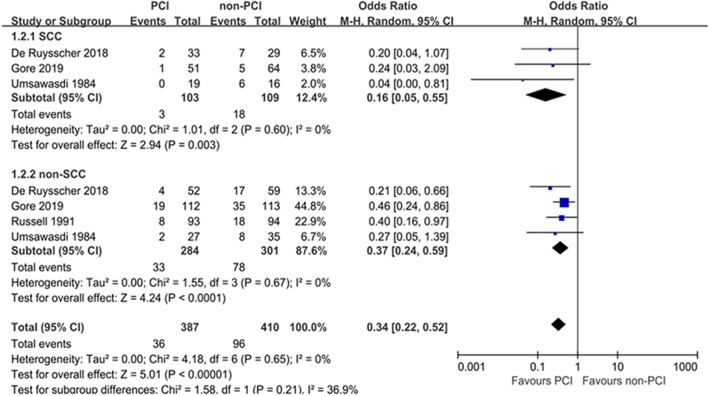
Subgroup analyses for BM according to pathology.